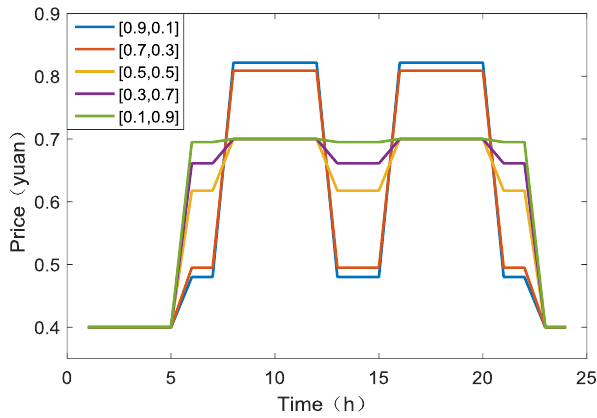
Figure 6. Prices of different weight coefficients.